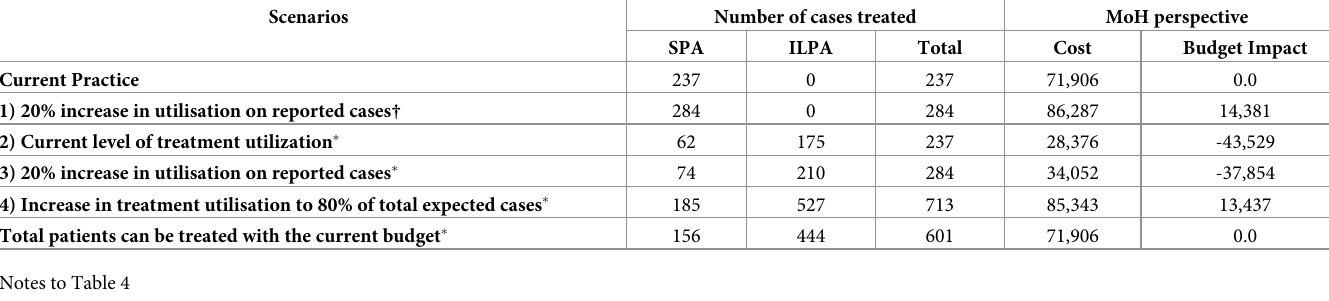
Table 4. Budget impact analysis from the MoH perspective